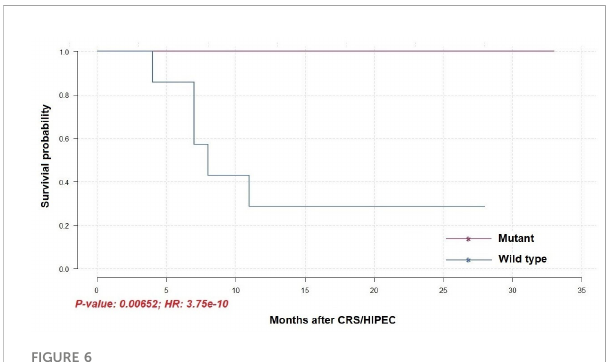
FIGURE 6 Overall survival of patients receiving CRS/HIPEC with or without a mutated AGAP5 gene (N = 14).